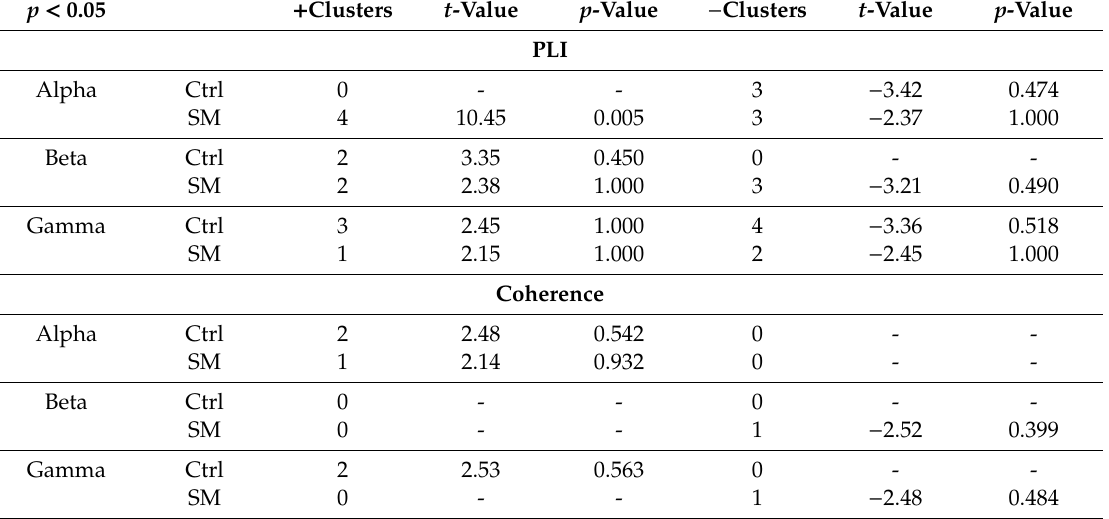
Table 3. The results of the non-parametric cluster-based permutation test comparing functional connectivity within the default mode network (DMN) for phase lag index (PLI) and coherence. The functional connectivity was compared from pre- to post-intervention (spinal manipulations (SM) and control (Ctrl)). The extent of changes from pre to post. The analysis was performed within alpha, beta, and gamma frequency bands. Positive ( + clusters) and negative ( − clusters) cluster count are shown, with t -value and p -values. Significant results ( p < 0.05) were highlighted with bold text. Ctrl denoted the comparison from pre to post in the Ctrl session, while SM denoted the comparison from pre to post in the SM session.